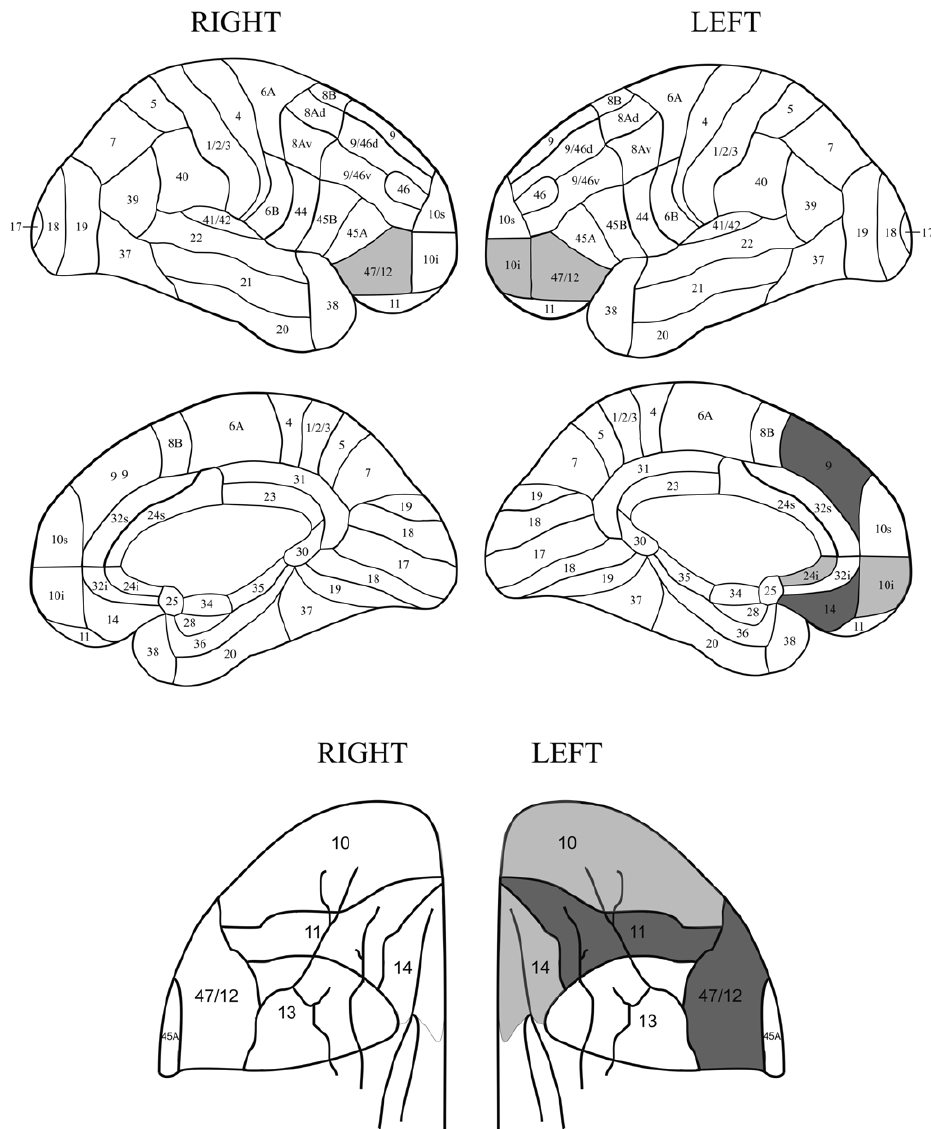
Figure 9. Relation of errors to lesions. Location of lesions with respect to the increased rate of errors in the Long Cue and Short Cue conditions combined. The fi gure shows regions where the error switch cost is largest. The dark grey shading indicates a region where the effect is signifi cant at the 0.05 level or better, with the light grey representing the 0.1 level. The diagrams of the orbital regions are placed so as to facilitate comparisons with the corresponding diagrams of the lateral and medial